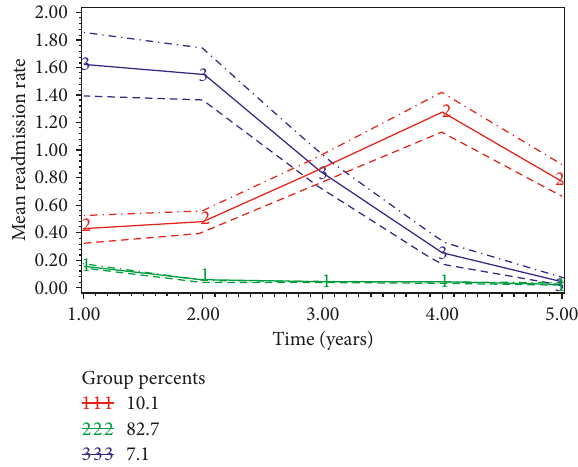
Figure 4: Subgroups among ruptured AAA repair patients and their trajectories of unplanned readmission rates (the horizontal axis starts with annual readmission rate at year one, and the dotted lines represent 95% confidence intervals for each